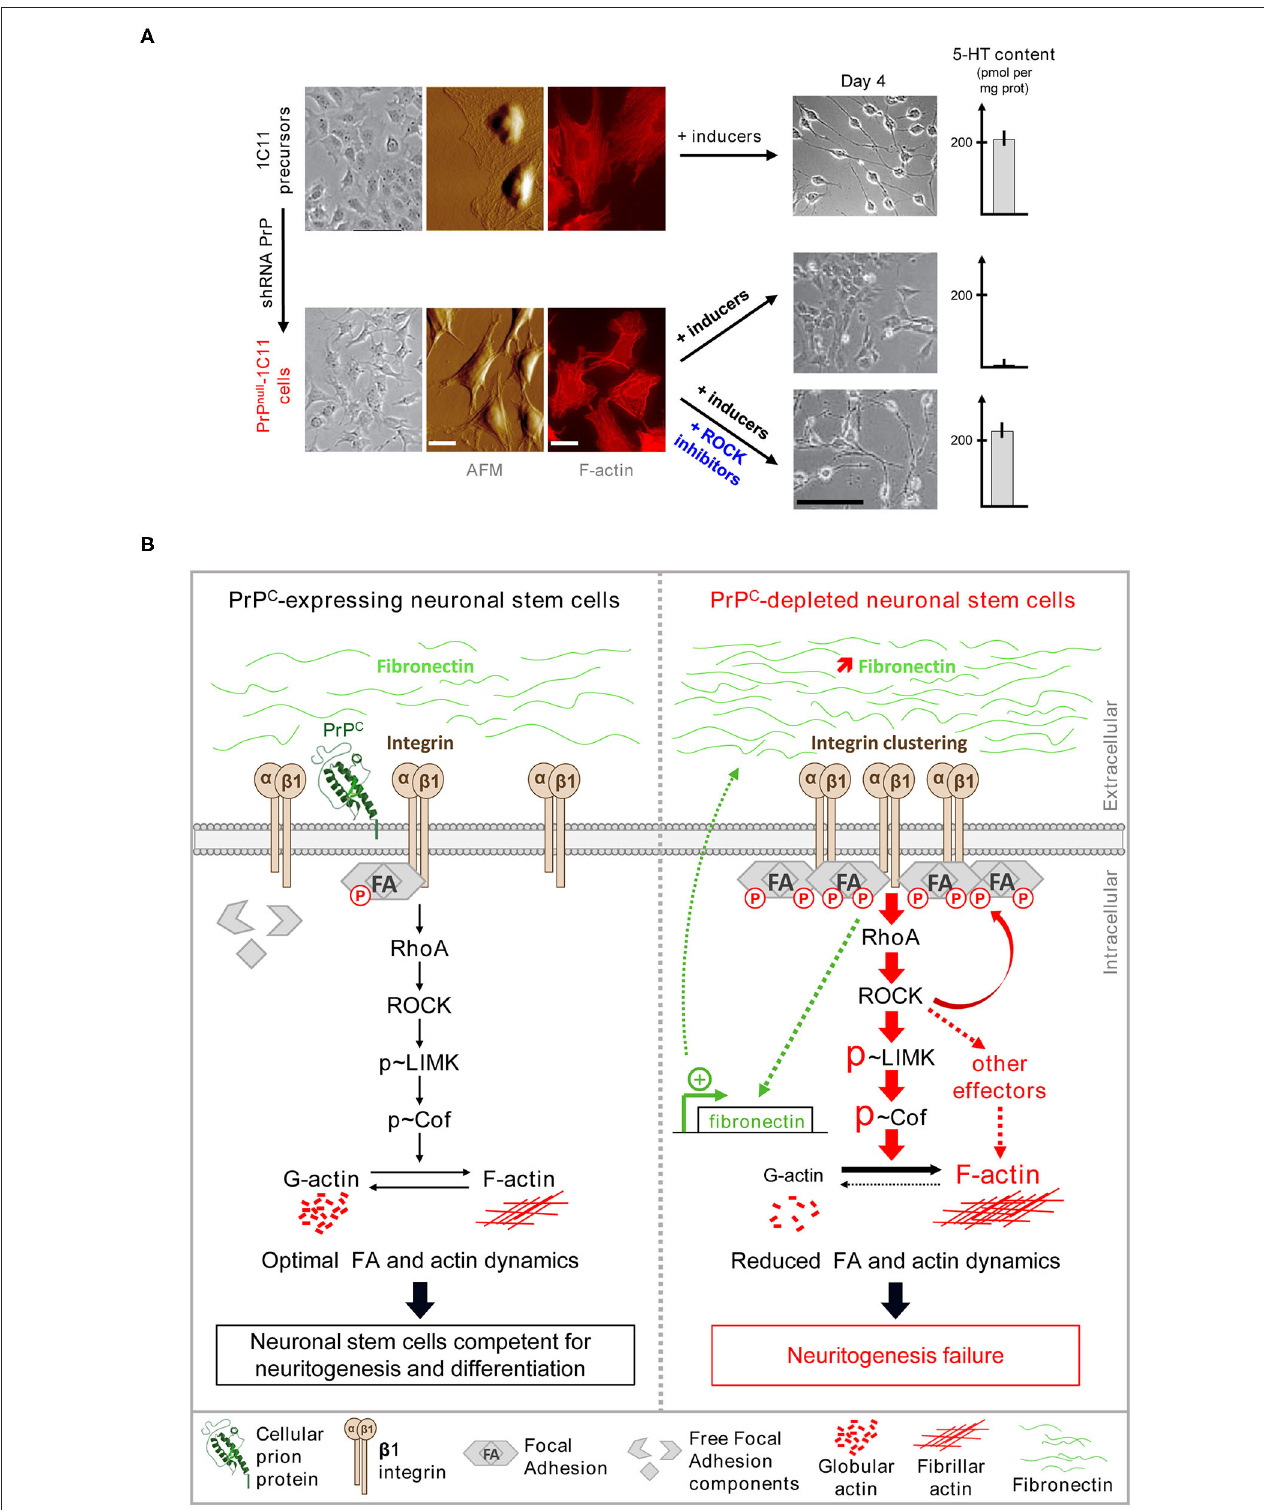
FIGURE 1 | PrP C renders neuronal stem cells competent for neuronal differentiation by toning down the β 1 integrins/ROCK signaling. (A) Stable PrP C depletion in 1C11 neuronal stem cells impairs neuritogenesis and the implementation of neuronal functions in a ROCK-dependent manner. shRNA-mediated chronic PrP C depletion in 1C11 cells (referred to as PrP null -1C11 cells) alters cell morphology as revealed by phase contrast microscopy and Atomic force microscopy (AFM)